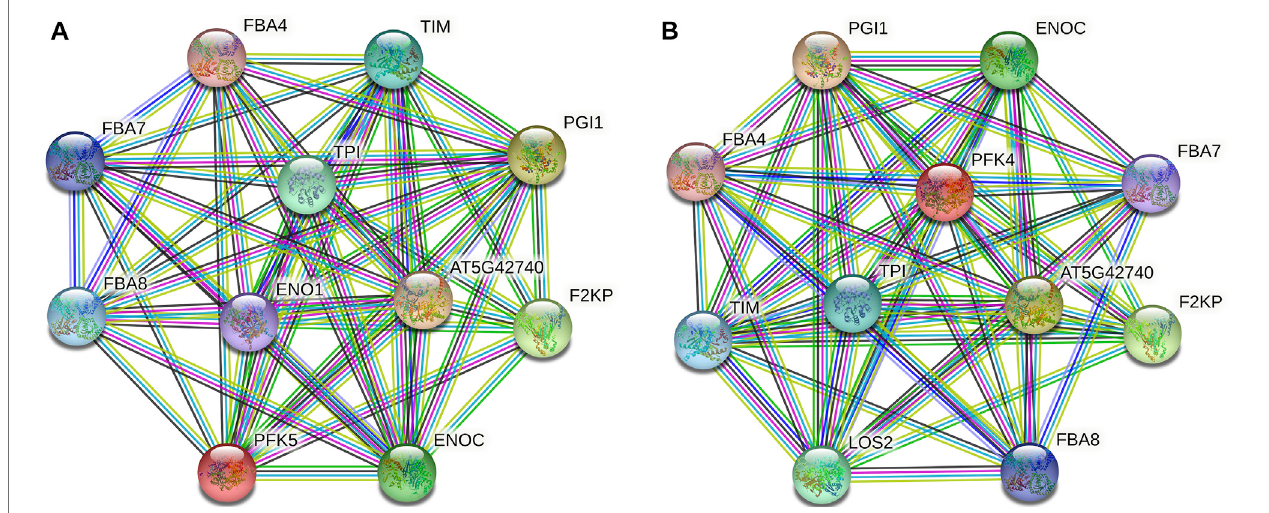
FIGURE 7 | Protein – protein interaction analysis of PFK hub proteins. (A) . Interaction network of GhPFK11 gene; (B) . Interaction network of GhPFK17 gene; Colored nodes: query proteins and fi rst shell of interactors; Red lines: gene fusions; Green lines: gene neighborhood; Black lines: co-expression; Blue lines: gene co-